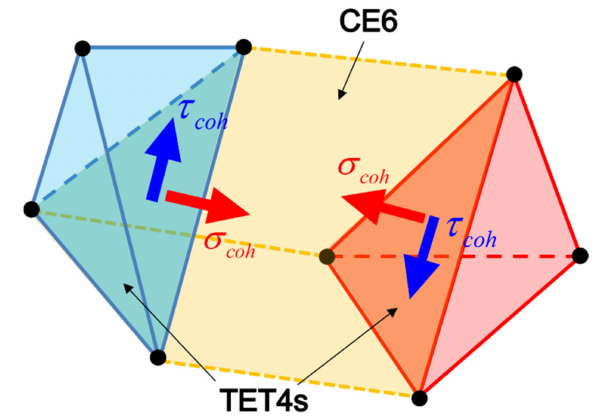
Figure 1. Two types of finite elements (TET4 and CE6) in 3D FDEM.